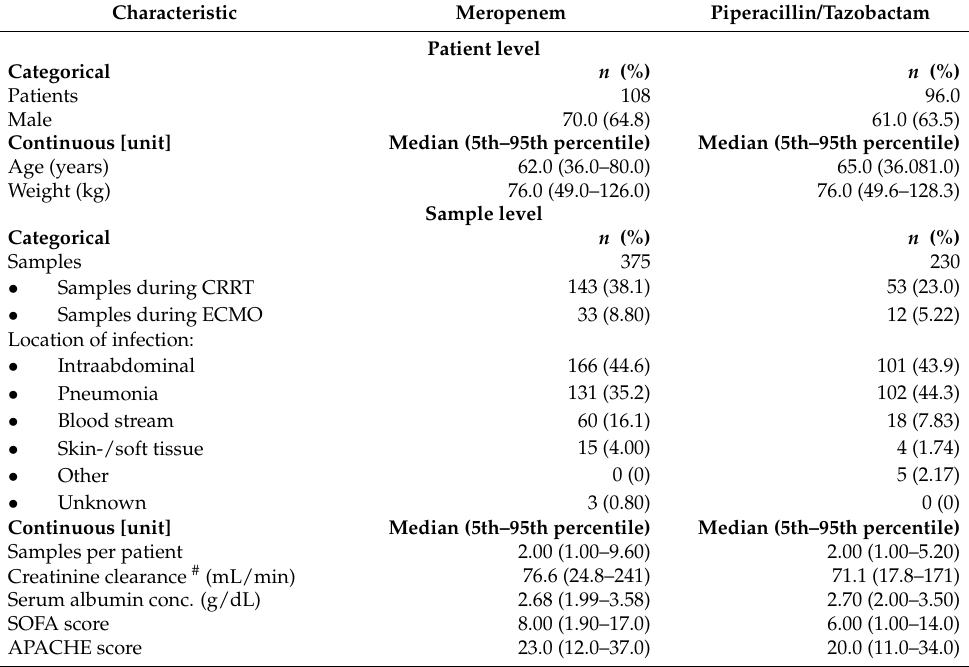
Table 1. Patient and sampling